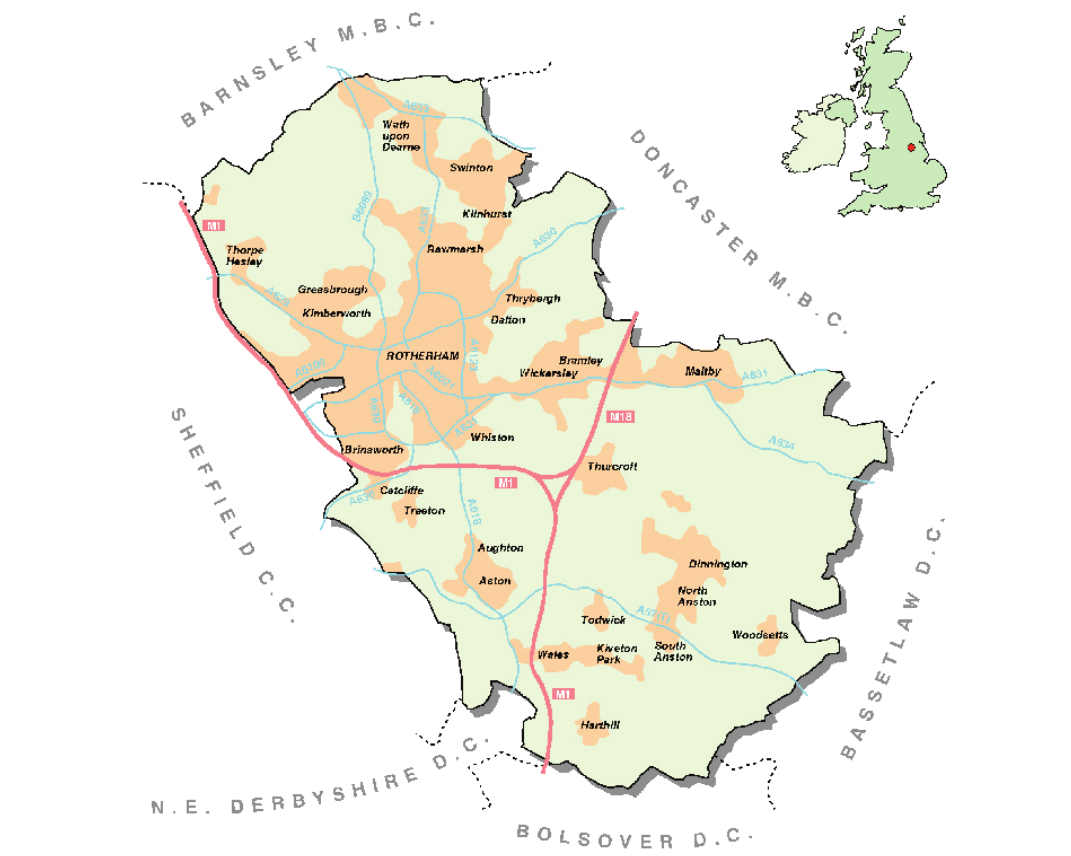
Figure 3: Map of